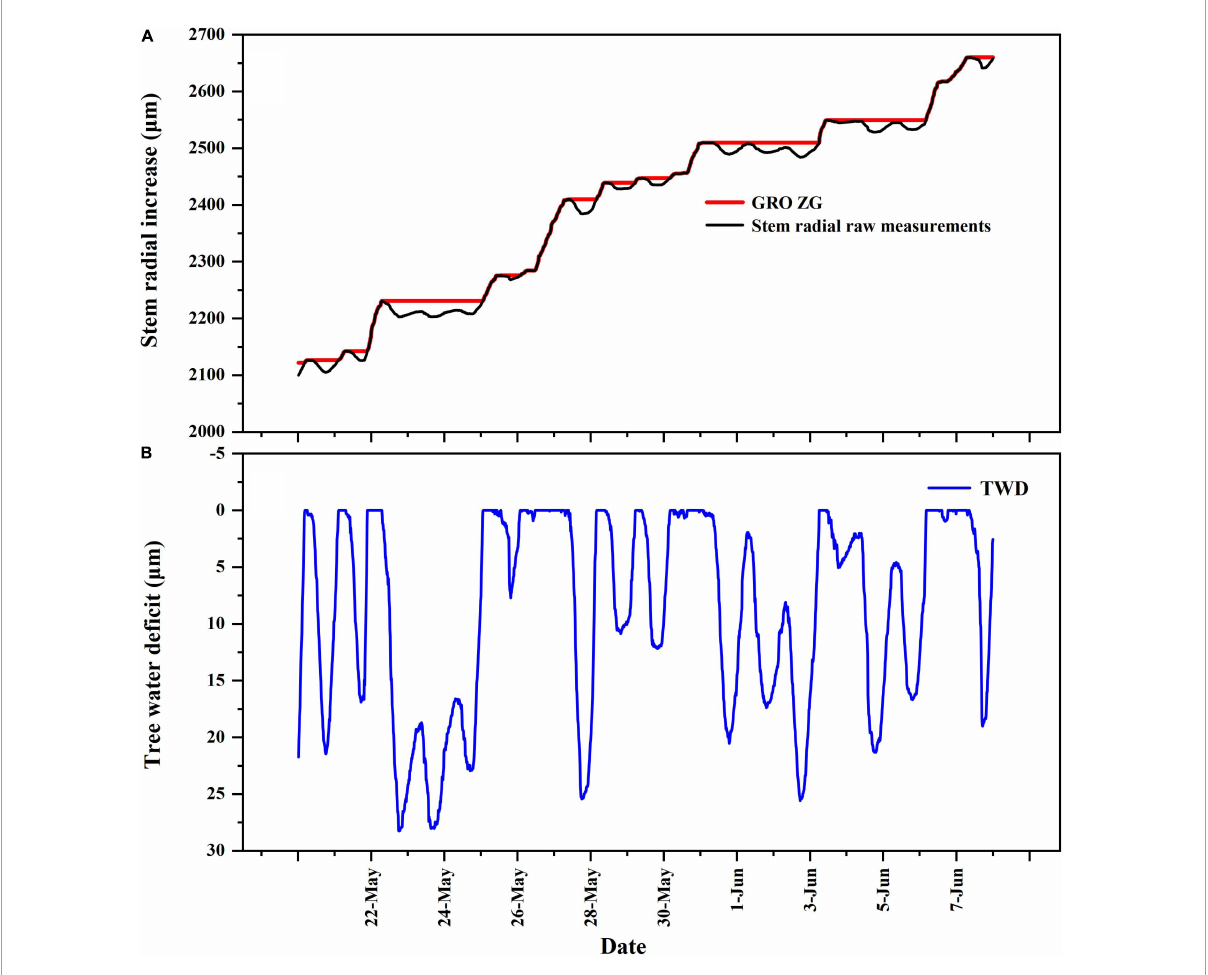
FIGURE3 Tree stem radial raw measurements (black line, A ) and the growth-induced irreversible stem expansion (GRO) according to the zero growth concept (red line, B ). The difference between irreversible growth and stem radial raw measurements is tree water deficit (TWD) (blue line, B ). Data are for the period from May 21 to June 8 in